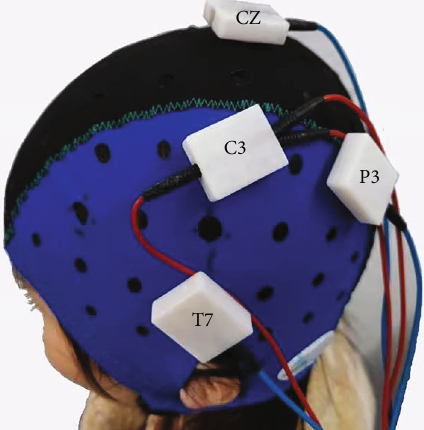
Figure 4: tDCS stimulation montage. Three anodal electrodes were connected to C3 silicone, and each cathodal electrode was connected to CZ, T7, and P3